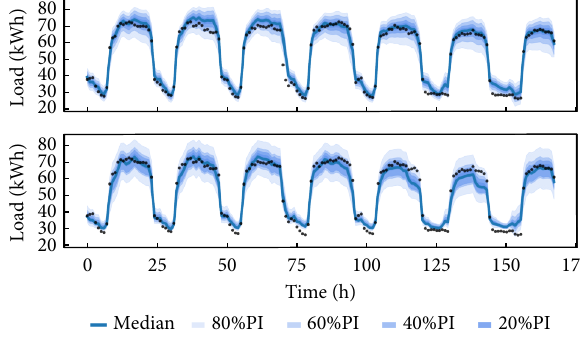
Fig. 8 Forecasts on Gerard. (up: MDARTS, down: QLSTM) 0.10